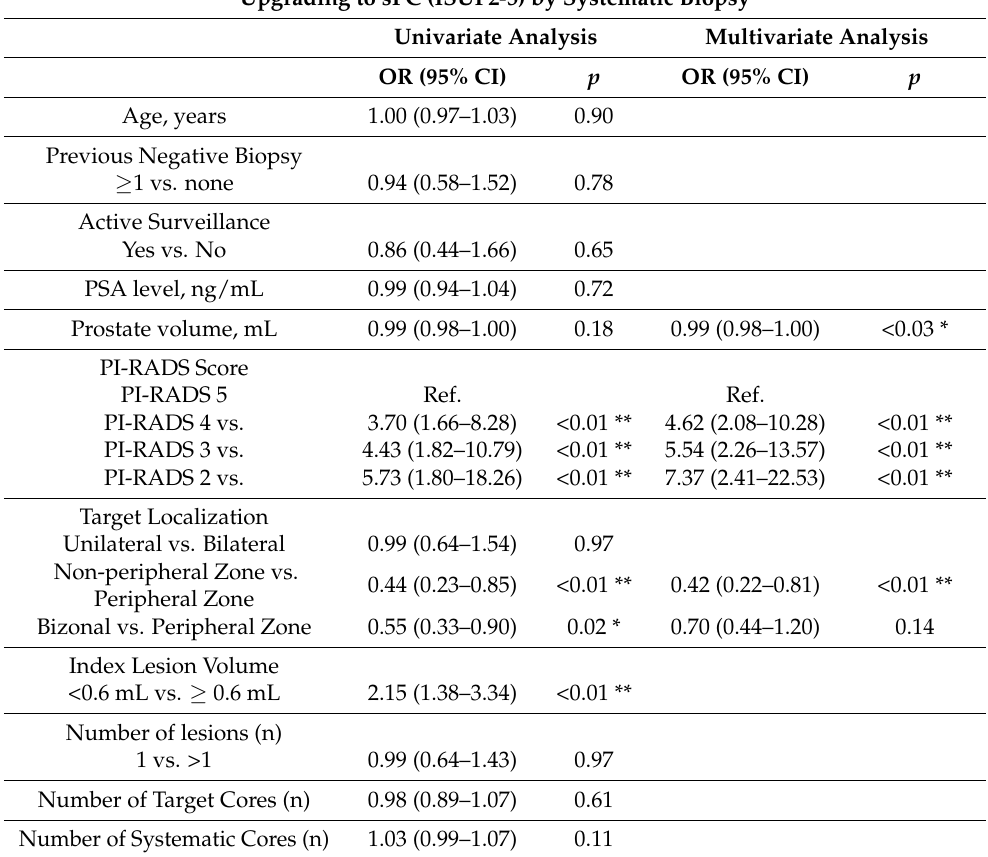
Table 2. Univariate and multivariate logistic regression analysis for upgrading to significant prostate cancer (ISUP2–5) by systematic biopsy. Backward stepwise elimination was applied for variable selection in multivariable analysis. sPC—significant prostate cancer (ISUP > 2); ISUP—International Society of Urological Pathology; OR—odds ratio; CI—confidence interval; PSA—prostate specific antigen; PI-RADS—Prostate Imaging Reporting and Data System. * p < 0.05; ** p < 0.01. Upgrading to sPC (ISUP2-5) by Systematic Biopsy Univariate Analysis Multivariate Analysis OR (95%